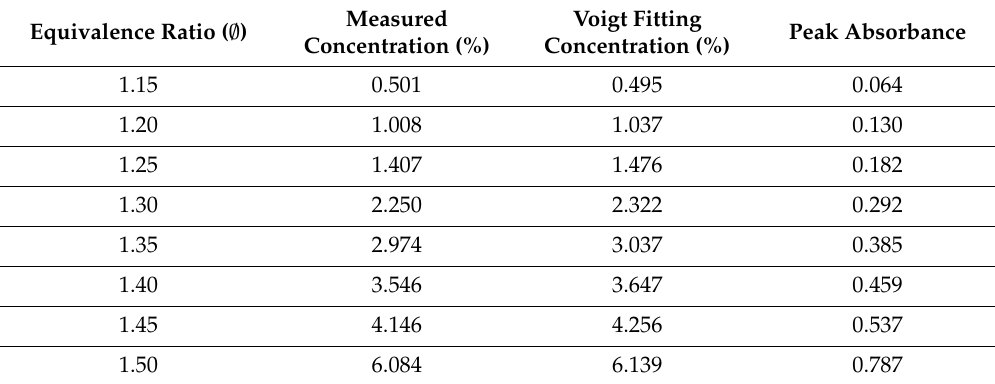
Table 3. Results of CO concentration and detection limit range for combustion